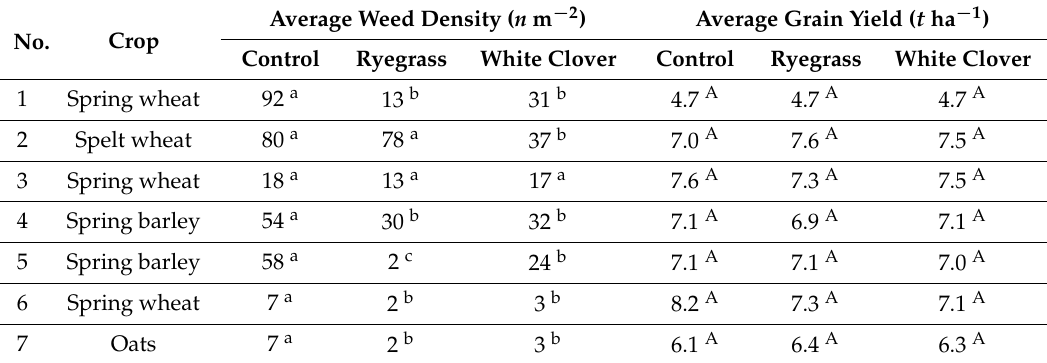
Table 3. Average weed densities ( n m − 2 ) and average grain yields ( t ha − 1 ) of the seven field experiments after late sowing of living mulch; Tukey-tests at a significance level of α ≤ 0.05 were performed for each single experiment; means with identical letters within each experiment do not differ significantly based on the Tukey-HSD test ( p < 0.05).